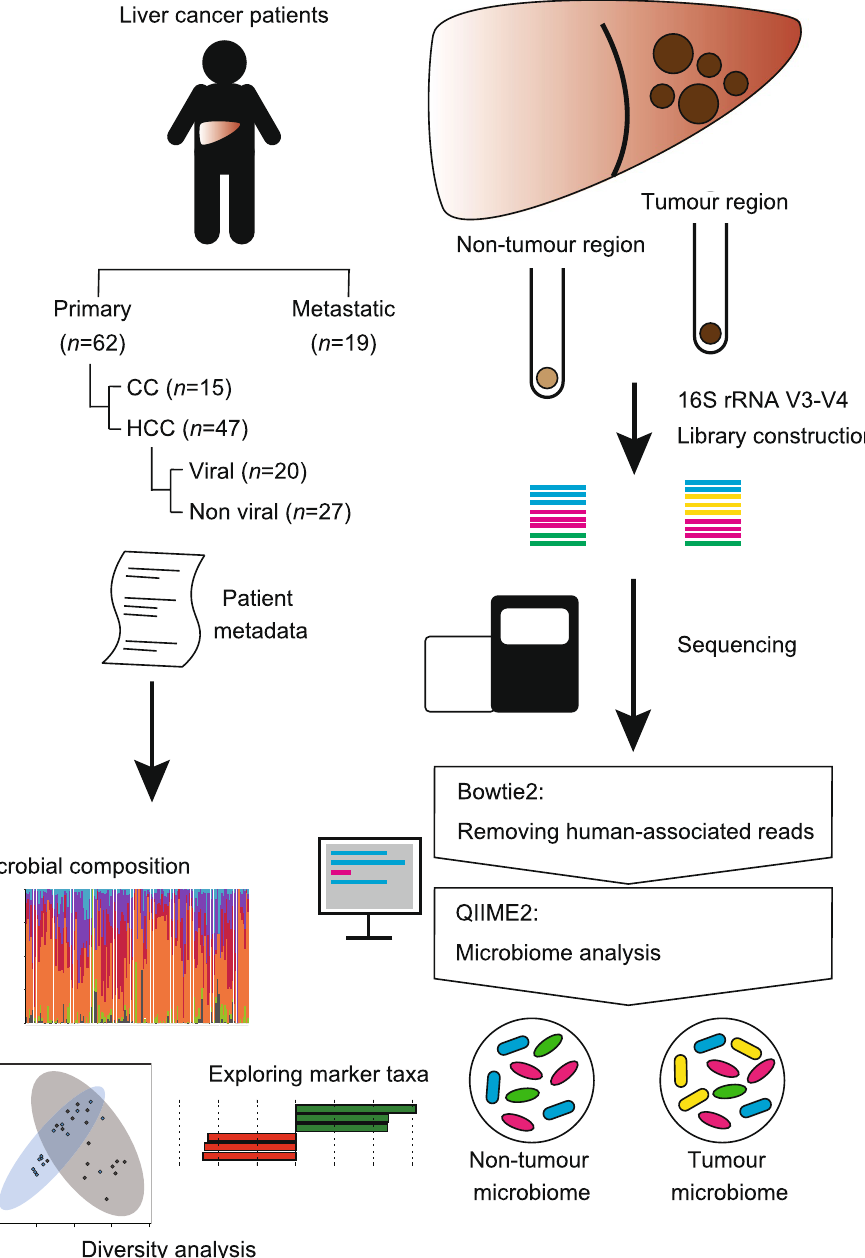
Figure 1. A scheme of the analysis of tumour-associated microbiota in the liver. CC cholangiocarcinoma, HCC hepatocellular